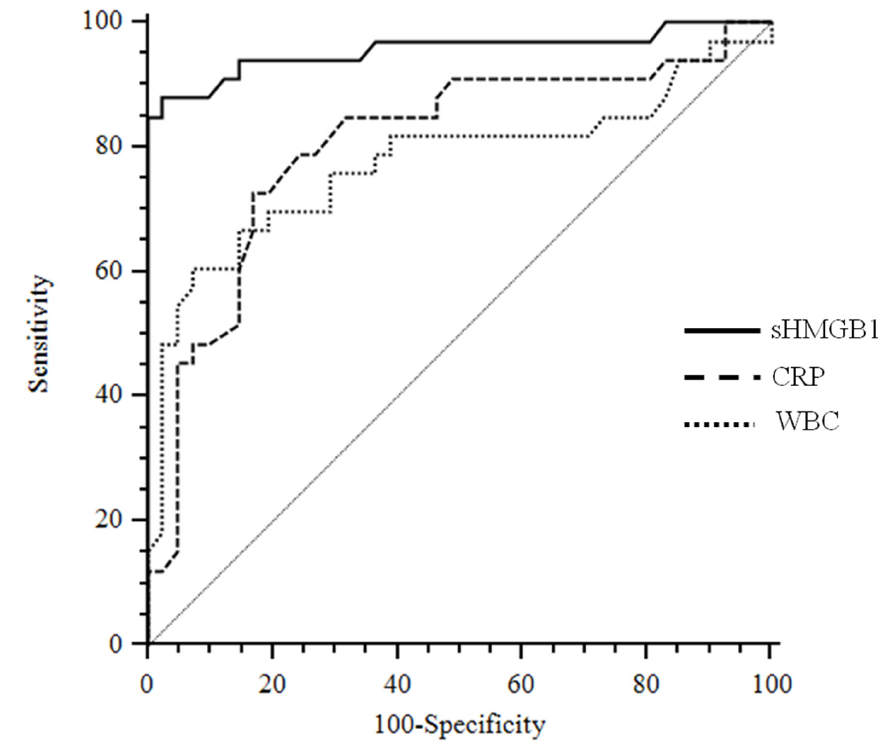
Figure 3. Receiver operating characteristics curves sHMGB1 considering APN as a status